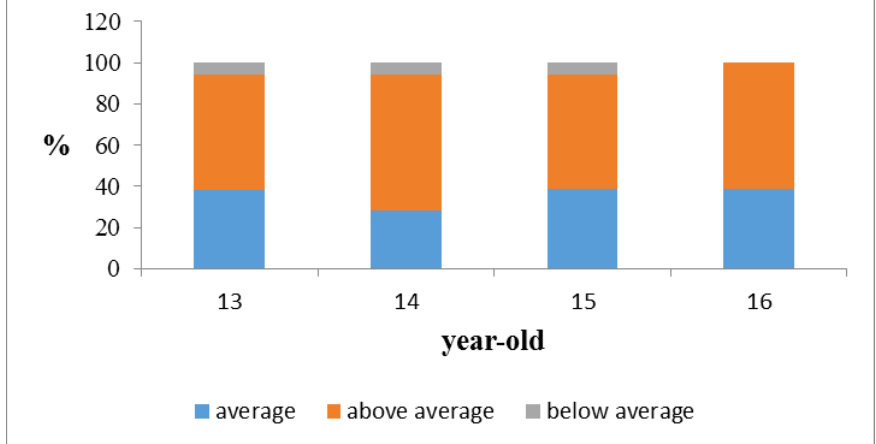
Fig. 2. Intra-group distribution of hockey players from 13 to 16 years old according to the body weight relative to nomograms